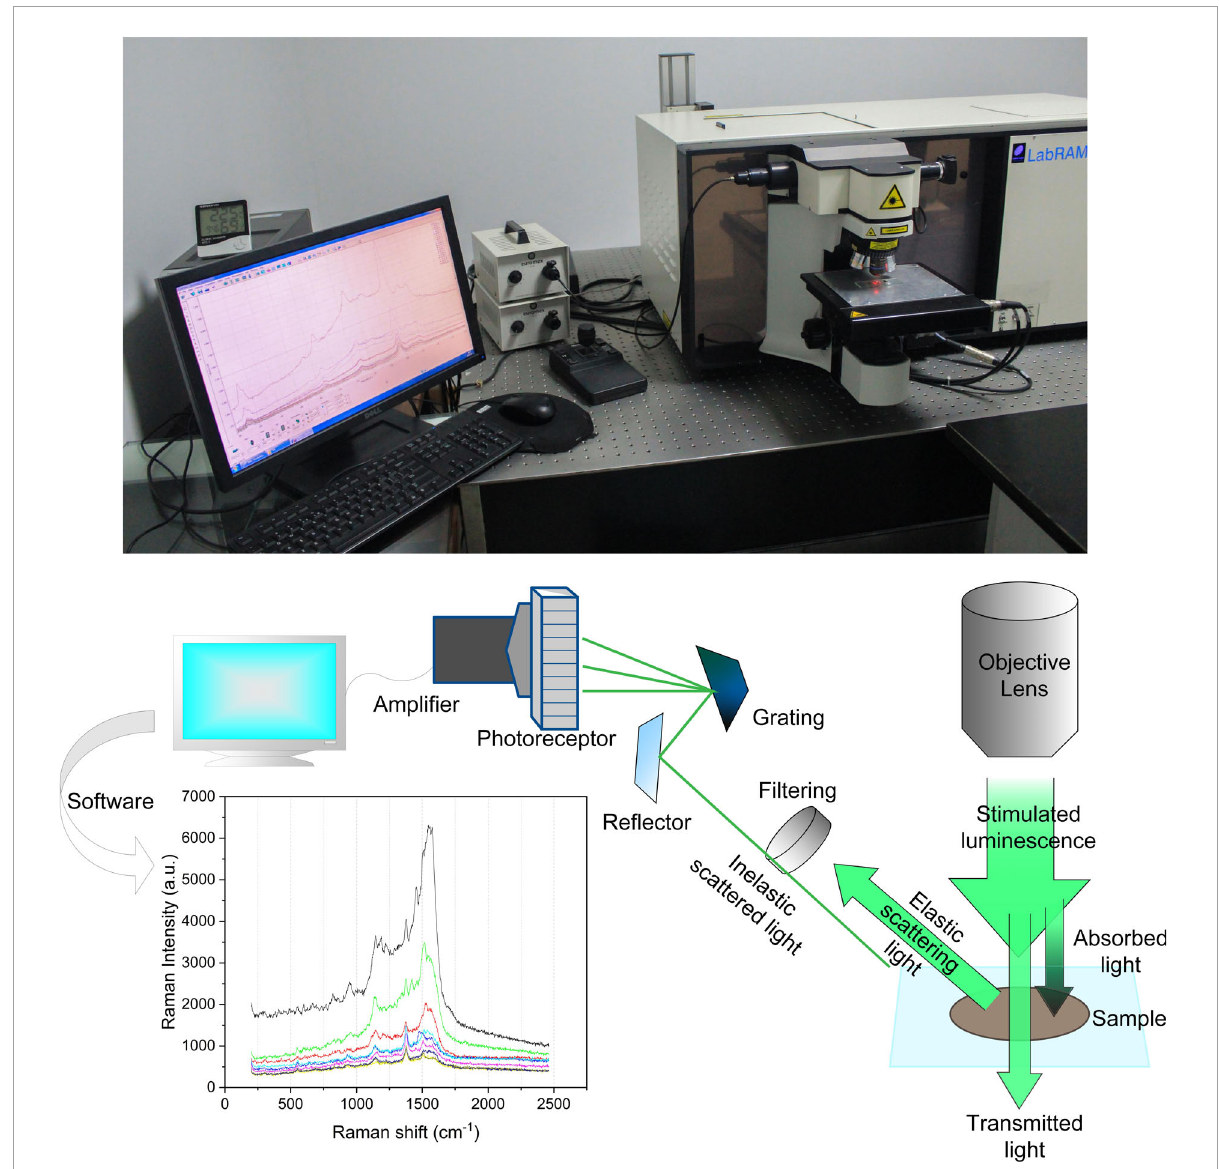
FIGURE1 The IoT environment for the detection of principal components of pesticide residues on the surface of fruits by Raman